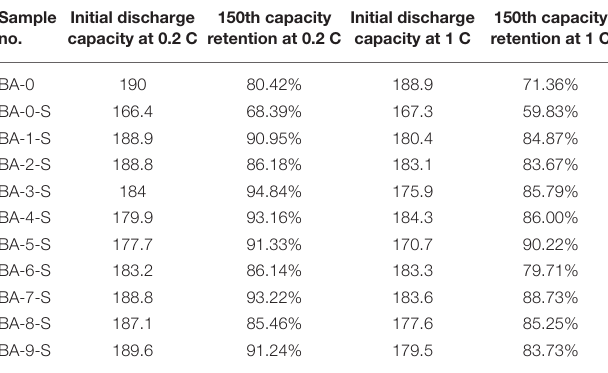
TABLE 2 | Summary of the electrochemical performances of all the samples. Sample no.